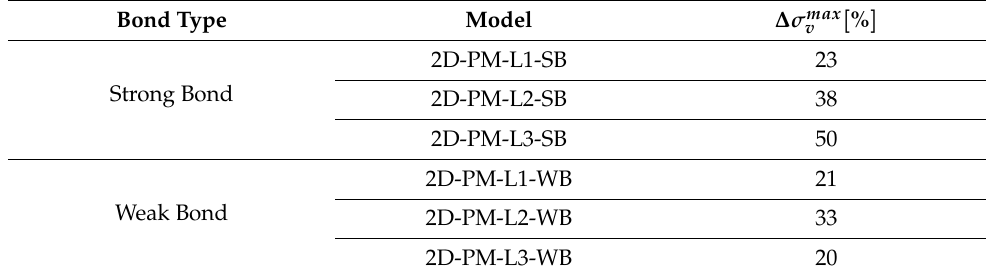
Table 6. Peak strength increase compared with the unreinforced wall 2D-PMR model.